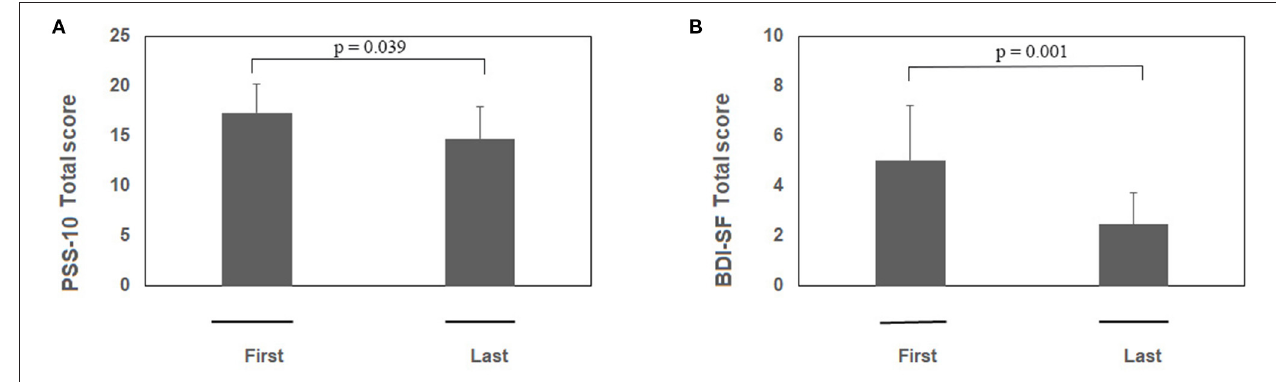
FIGURE 1 | (A,B) RR training modulates both PSS-10 and BDI-SF total scores. Subjects were exposed to RR training and at the beginning of each session both questionnaires were administered. Histograms showing the PSS-10 (A) and BDI-SF (B) scores between first and last session during RR training ( n = 23). Note the significant decreases in both PSS-10 and BDI-SF total scores between the pre first and pre last sessions during RR training. Data are presented as mean values (Mean ± SEM) and comparisons between groups were carried out by Wilcoxon test. Significance was set at p ≤ 0.05.